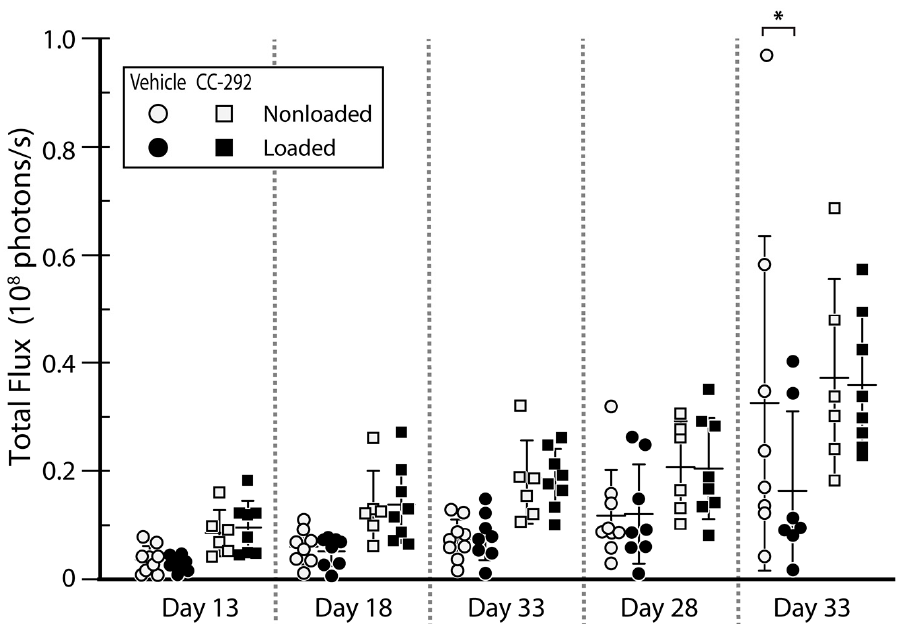
Figure 4. BLI analysis of vehicle and CC-292 treated mice. BLI signals (total flux in photons/sec) of MM-injected mice treated with vehicle (circles) or CC-292 (squares), nonloaded (white), and loaded (gray) at days after inoculation (mean ± SD). Two-way ANOVA followed by Tukey–Kramer post-hoc test, * p < 0.05.